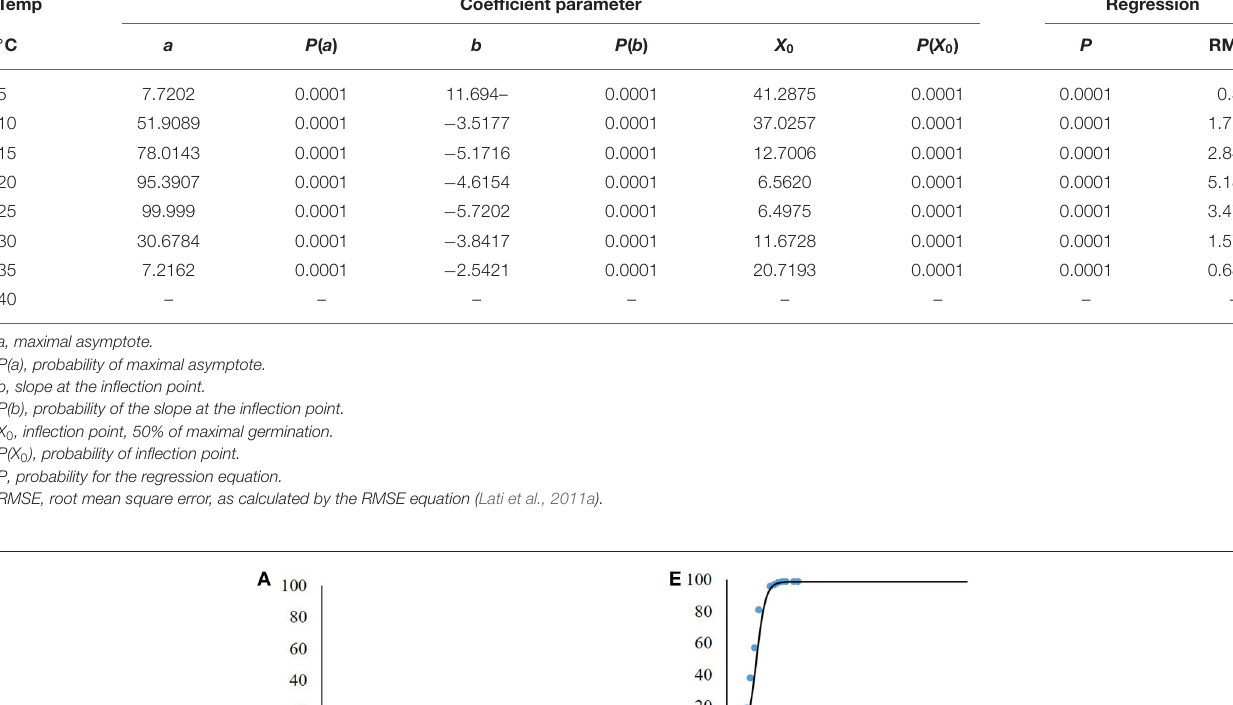
Frontiers in Agronomy |